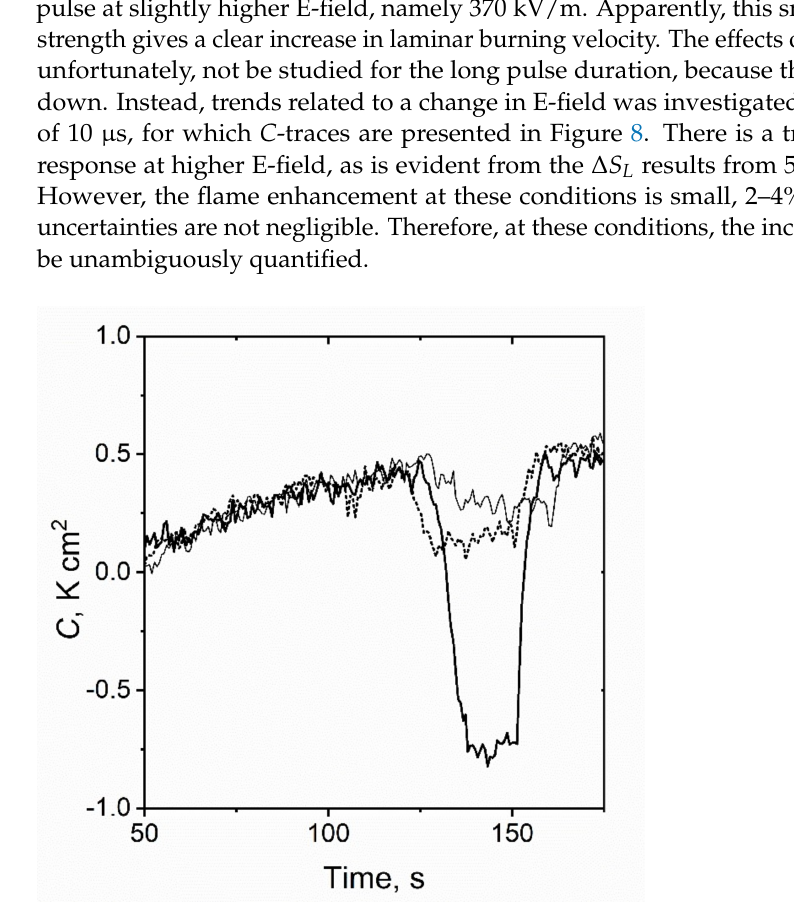
Figure 6. Trace of coefficient C for flames at φ = 0.7 and V g = 17.0 cm/s, E RMS = 350 kV/m for pulse sequences 50 µ s/1 kHz (thick solid line), 25 µ s/2 kHz (dashed line), and 10 µ s/5 kHz (thin solid